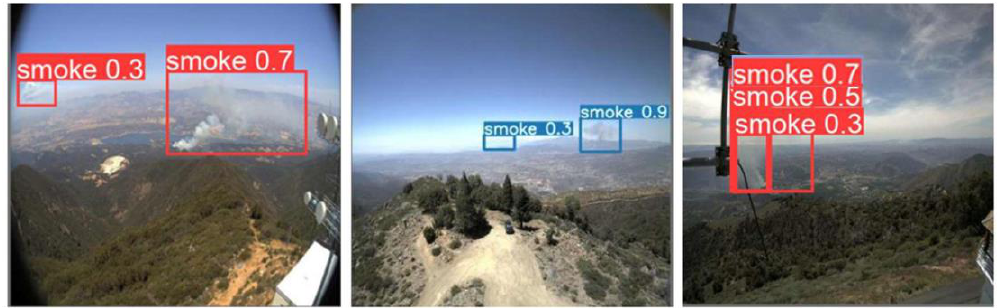
Figure 13. A sample of wrongly detected clouds as fire smoke.